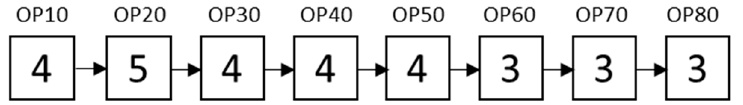
Figure 12. Workcenters arrangement of the production system. The number indicates the amount of machines for each workcenter.